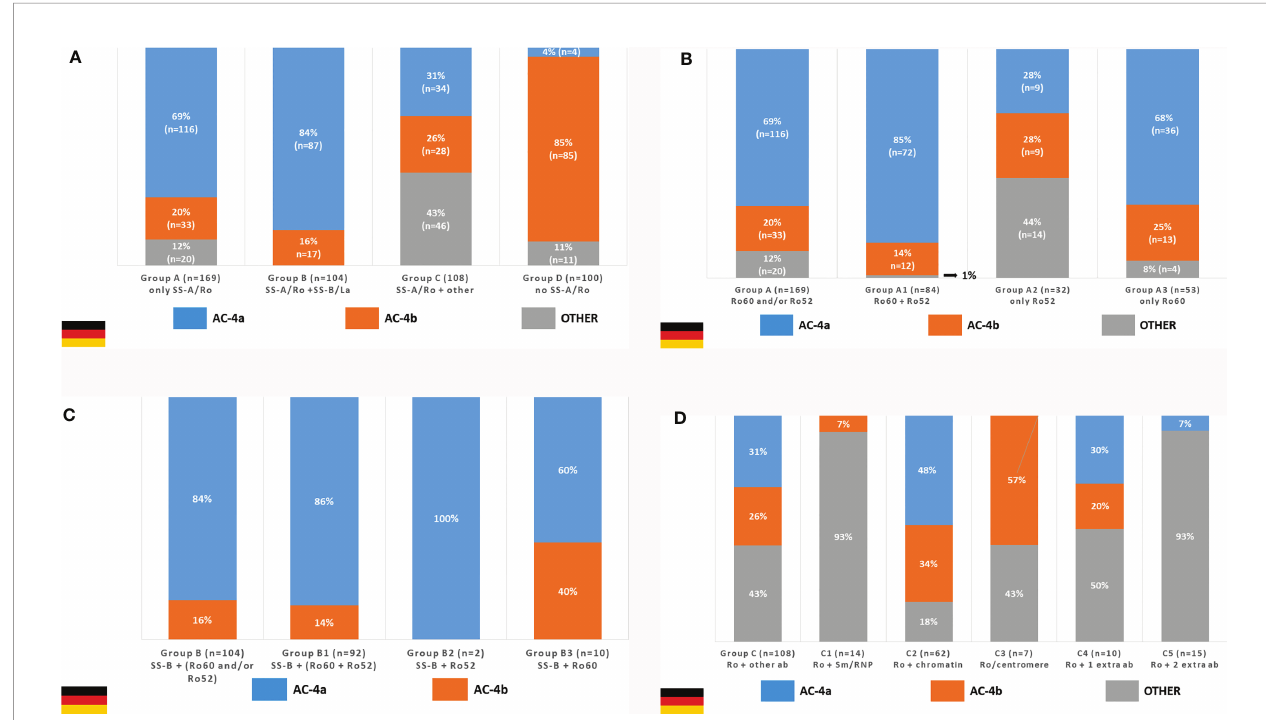
FIGURE 9 | Frequency of the AC4a pattern and other patterns in samples with different combination of autoantibodies according to data from the Technical University Dresden, Germany. (A) The AC-4a pattern is more frequent in samples with anti-SS-A/Ro only or in combination with anti-SS-B/La as compared with samples with anti-SS-A/Ro plus other autoantibodies (dsDNA, nucleosome, Sm, U1-RNP, SS-B/La, Scl-70, Jo-1) and samples with no reactivity to SS-A/Ro. (B) In the group with sole reactivity to SS-A/Ro, those that contain anti-Ro60 antibodies show higher frequency of the AC-4a pattern than those with exclusive reactivity to Ro52. (C) The coexistence of anti-SS-B/La did not disturb the association of anti-SS-A/Ro antibodies and the AC-4a pattern. (D) The presence of other DAA prevented the appearance of the AC-4a pattern in the majority of SS-A/Ro-reactive